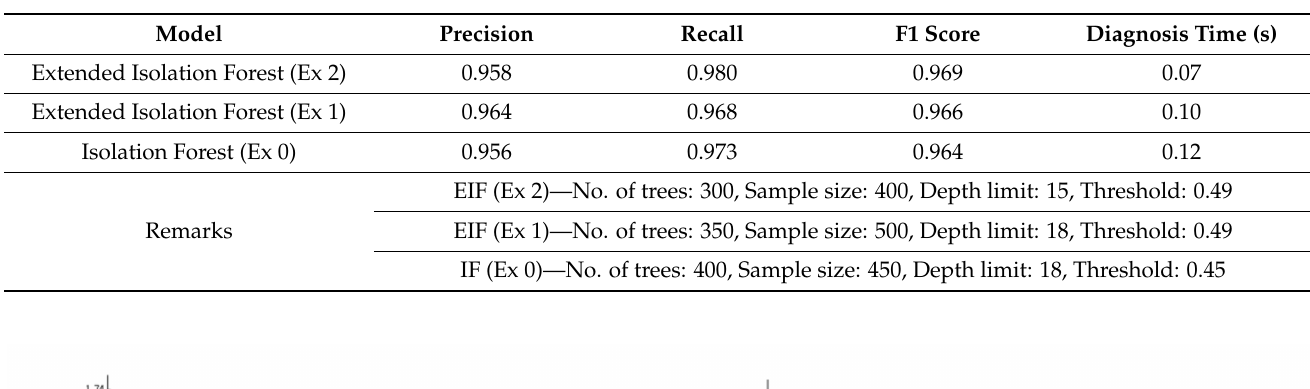
Table 7. Fault detection results of each model.